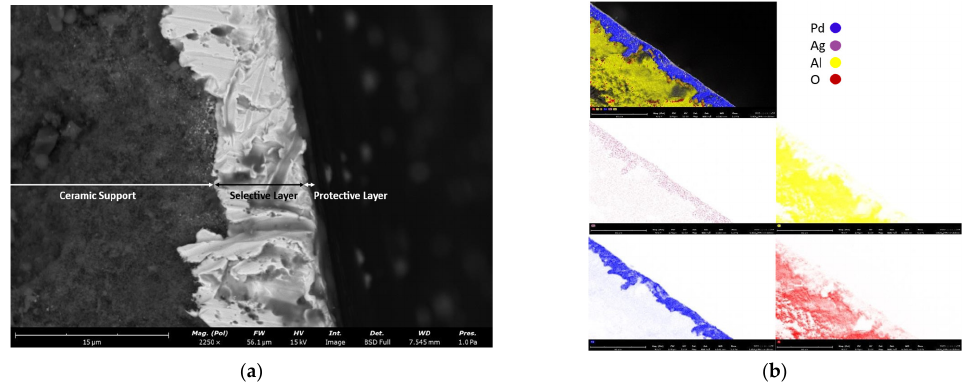
Figure 3. SEM ( a ) and EDX ( b ) image of the cross-section of the double-skinned Pd–Ag membrane used in this work.